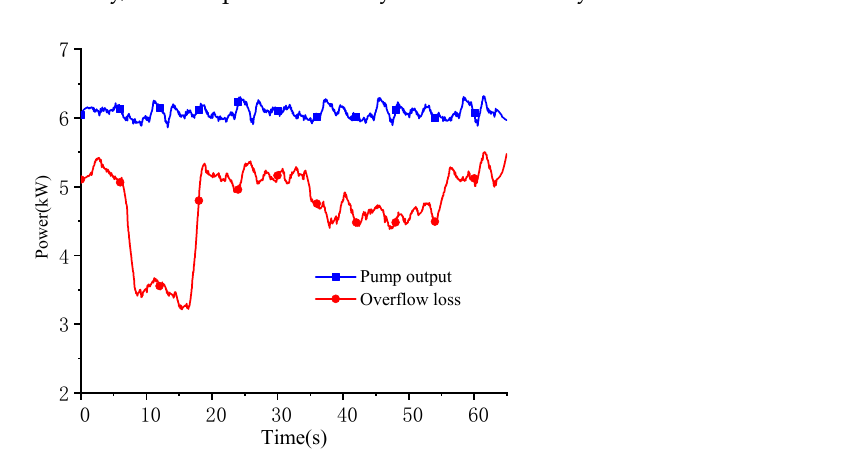
Figure 34. Power consumed in throttle-governing system without the energy regeneration system.